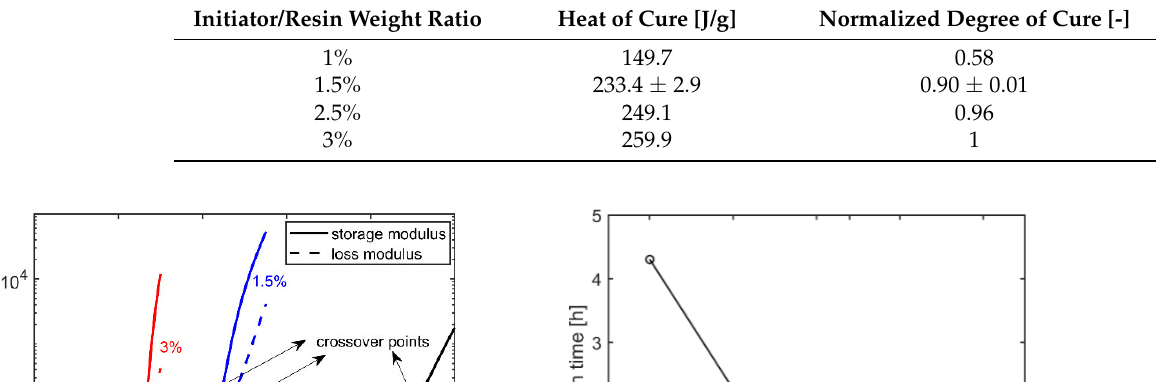
Figure 2. DSC curves of UPR–MEKP mixture for different MEKP/UPR weight ratios. Table 1. Heat of cure calculated from the DSC curves and the degree of cure normalized with respect to the heat of cure of mixture with 3% initiator (table shows mean values. Only for 1.5%, ± one standard deviation is also given, as 3 specimens were tested at that ratio). Initiator/Resin Weight Ratio Heat of Cure [J/g] Normalized Degree of Cure [-]